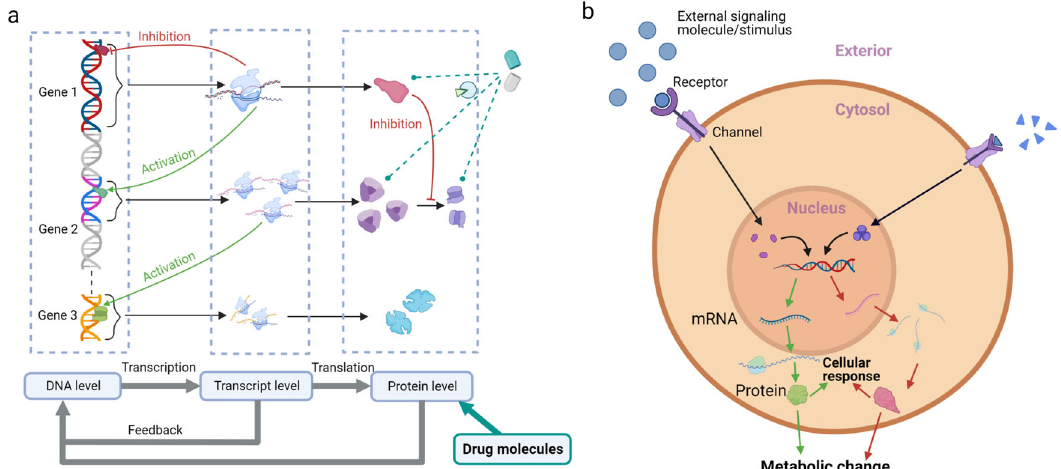
Fig. 6 Schematic diagrams in dynamic modeling. a Gene regulatory network adapted from the work 25 . Gene 1, 2, and 3 are coding genes. Gene 1 regulates its own expression and those of Gene 2. The protein produced by Gene 1 regulates Gene 3 expression through a signaling factor/protein (that is produced from the protein expressed by Gene 2.) Drugs can intervene in the regulation by binding with proteins that change the gene expressions. b Diagram of signaling transduction. Signals are received and enter the nucleus to change gene expression. Proteins are synthesized to regulate phenotypic behaviors of cells or tissue. Errors (e.g., dysregulation) in signaling pathways (e.g., dysregulation) may cause the ceasing of cell apoptotic that results in unlimited growth and